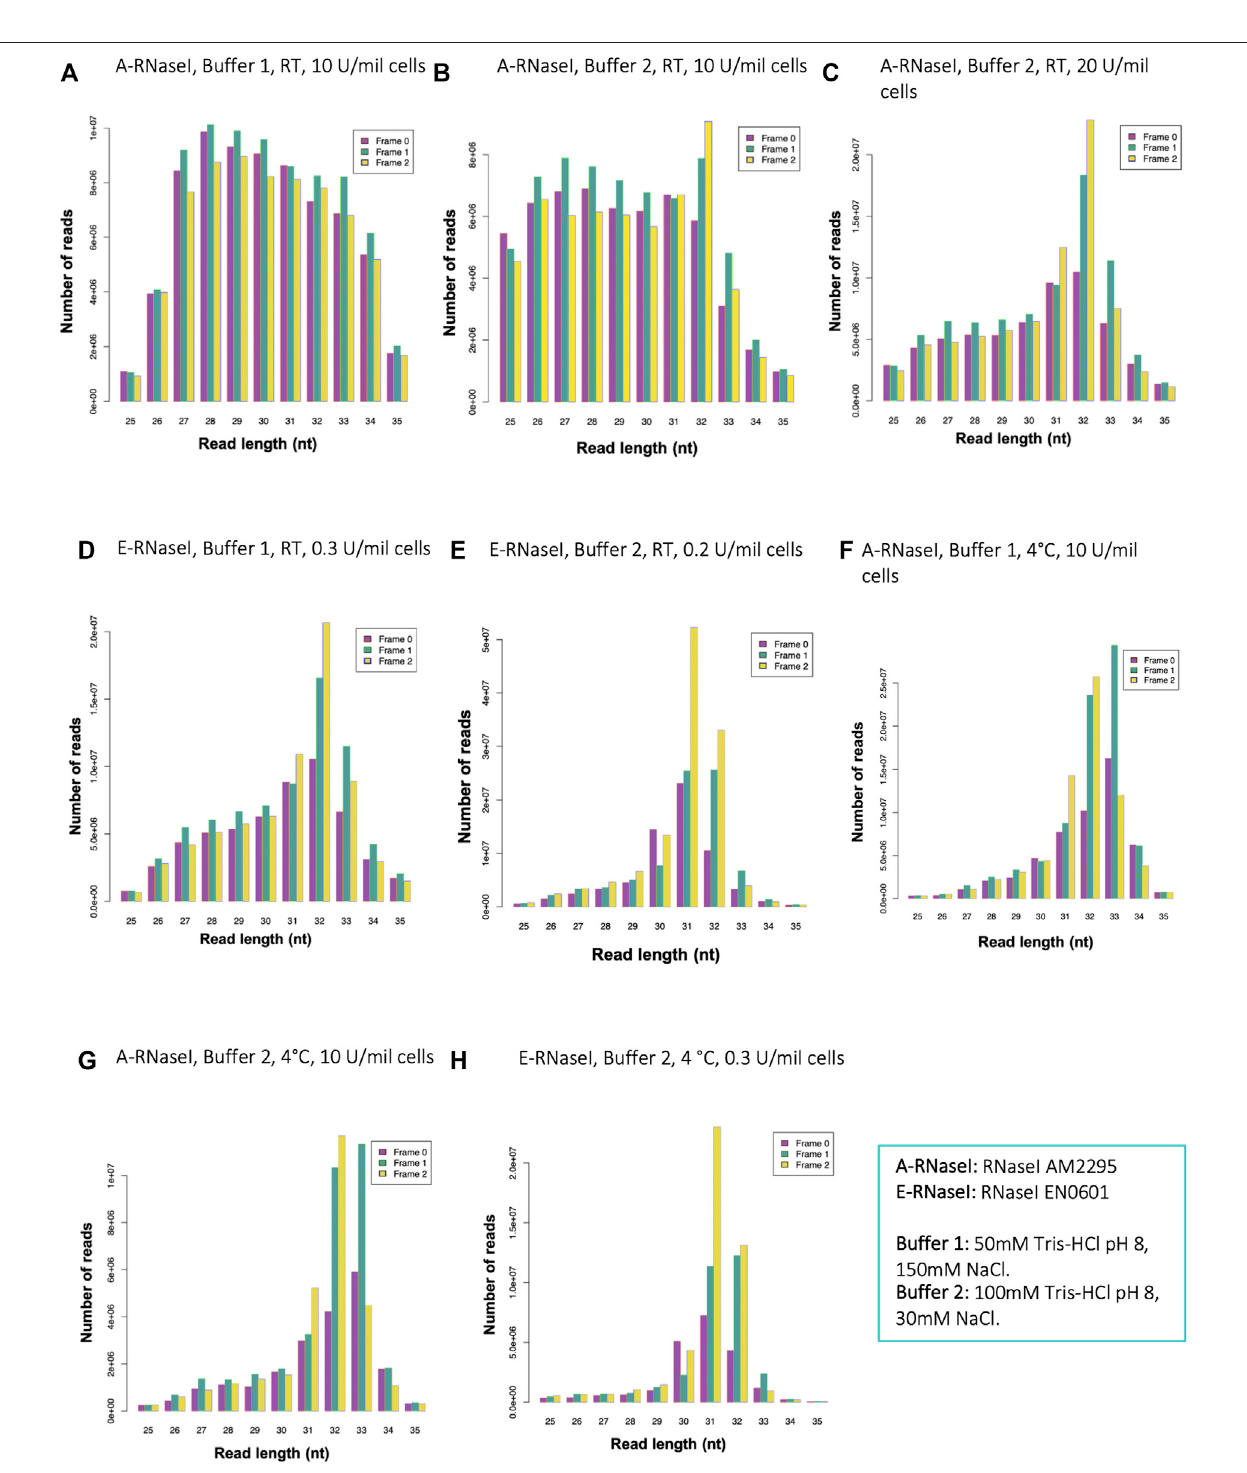
FIGURE 1 | Changes to RNaseI footprinting affects size and framing of ribosome footprints in human SH-SY5Y cells. Read length distribution and frame plots, generated by RiboSeqR, from ribosome footprinting in cells SH-SY5Y under different conditions: (A) Buffer 1 (50 mM Tris-HCl pH8, 150 mM NaCl), RT 1 h, with A-RNaseI 10U/millioncells, (B) Buffer 2 (100 mM Tris-HCl pH8, 30 mM NaCl), RT1 h, with A-RNaseI 10 U/million cells, (C) Buffer 2, RT1 h, with A-RNaseI 20 U/million cells, (D) Buffer 1, RT 1 h, with E-RNaseI 0.3 U/million cells, (E) Buffer 2, RT 1 h, with E-RNaseI 0.2 U/million cells, (F) Buffer 1, O/N at 4 ° C, with A-RNaseI 10 U/ million cells, (G) Buffer 2, O/N at 4 ° C, with A-RNaseI 10 U/million cells, (H) Buffer 2, O/N at 4 ° C, with E-RNaseI 0.3 U/million cells. See Table 1 for full details of each condition tested.